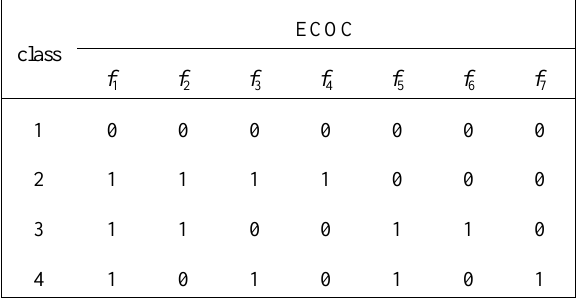
Table 1. An error correcting coding matrix for class number k